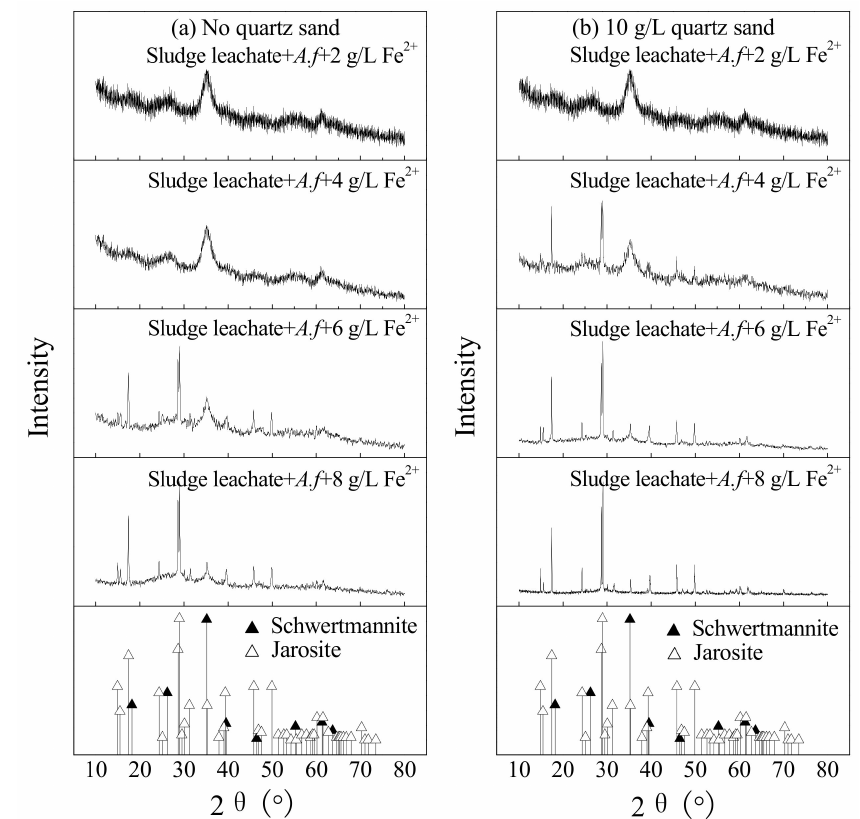
Figure 5. The XRD pattern of biogenic secondary iron minerals under different treatments at 28 ◦ C and 180 rpm for 120 h: ( a ) no quartz sand; ( b ) 10 g · L − 1 quartz sand (initial pH = 2.55, Fe 2+ concentration = 2–8 g · L − 1 , sludge leachate volume = 270 mL, A. ferrooxidans LX5 volume = 30 mL, A. ferrooxidans LX5 density = 5 × 10 7 cells · mL − 1